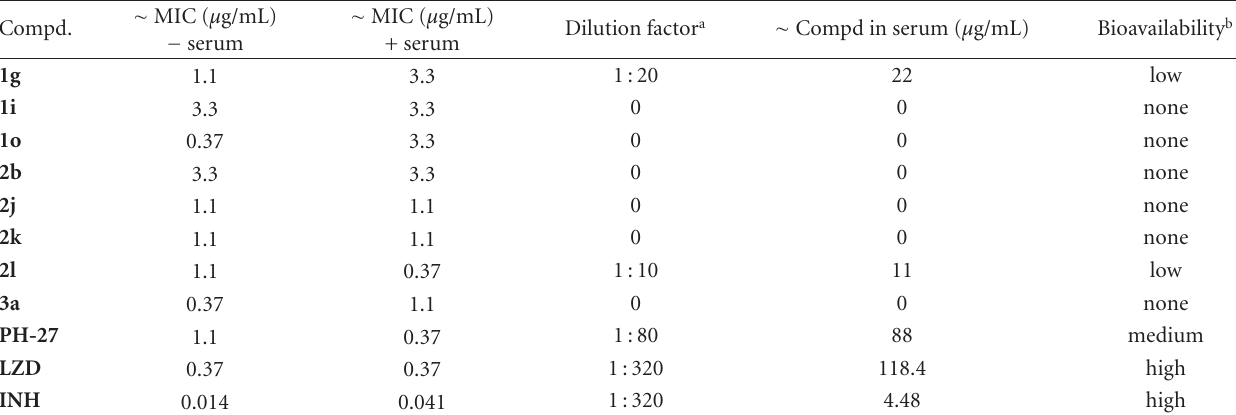
Table 3: In vivo bioavailability of selected oxazolidinones.